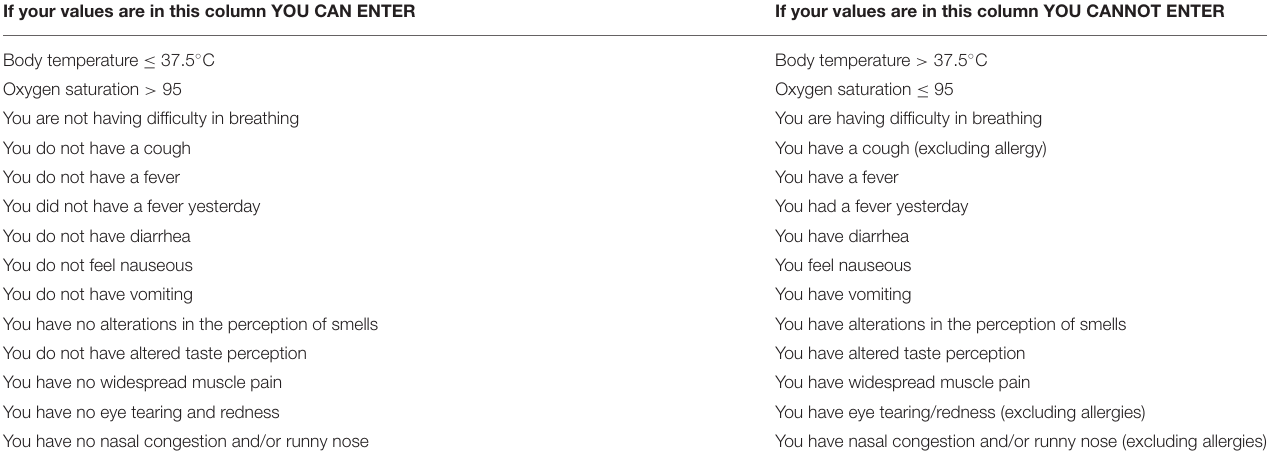
TABLE 1 | Checklist to screen workers before entering the workplace. If your values are in this column YOU CAN